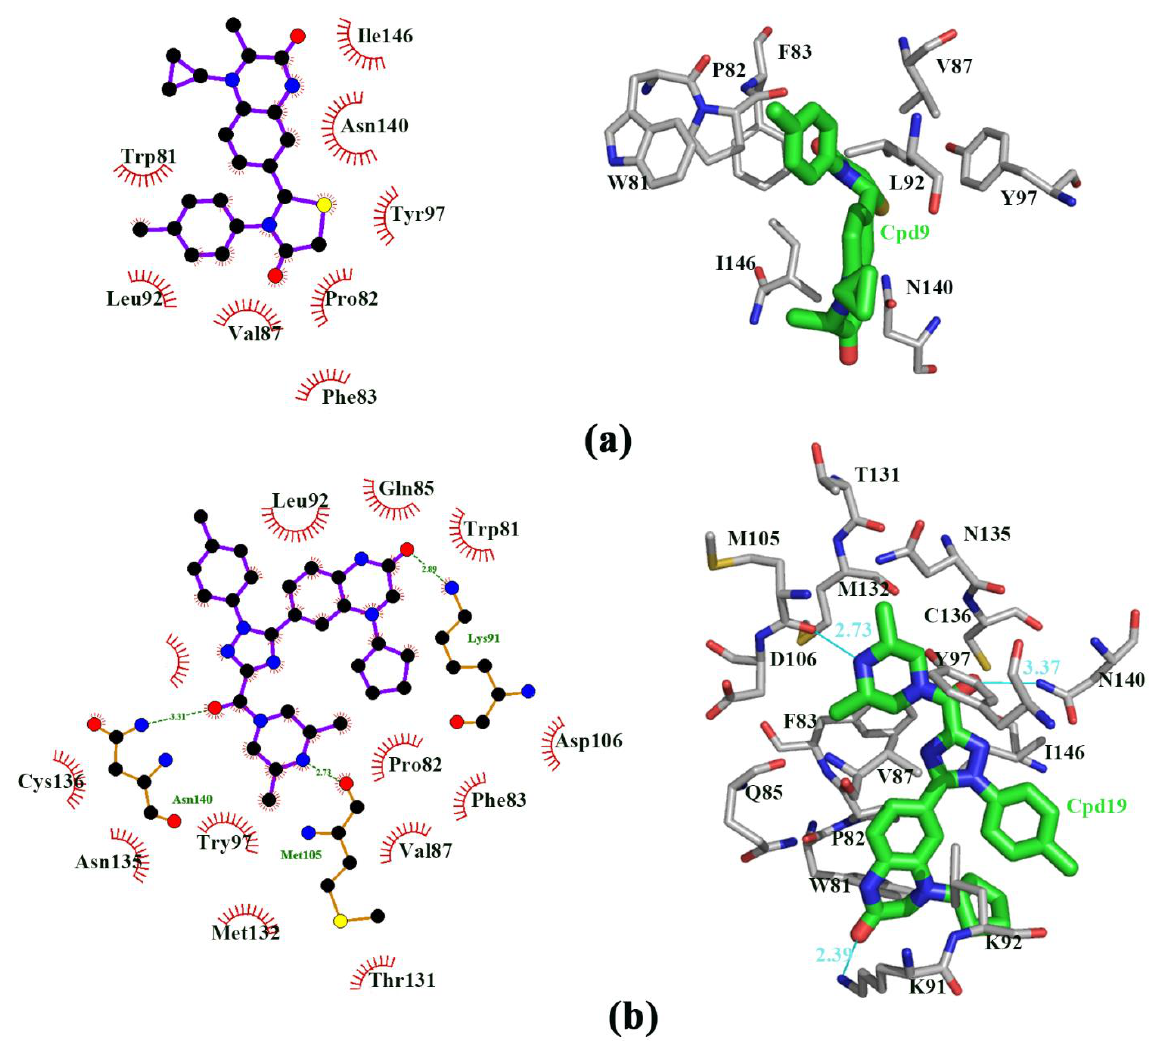
Figure 2. The binding pocket of ( a ) the active residues around Cpd9 binding to BRD4. ( b ) the active residues around Cpd19 binding to BRD4.